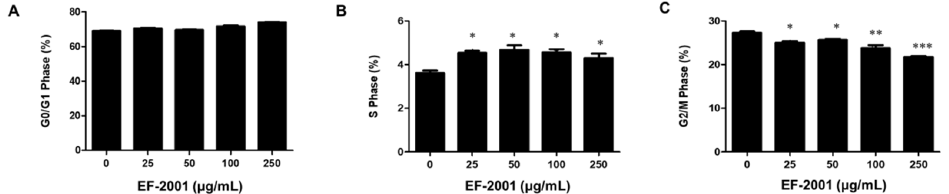
Figure 4. Effects of EF-2001 on MDI-induced cell cycle progression in 3T3-L1 adipocytes. MDI-treated 3T3-L1 preadipocytes were cultured with DM in the presence or absence of EF-2001. Cells treated with MDI for 48 h were stained with propidium iodine (PI) and analyzed by flow cytometry. The percentages of the cell population at G0/G1 ( A ), S ( B ), and G2/M ( C ) phase of the cell cycle were calculated from the data. Data are represented as mean ± SEM. ( n = 4); * p < 0.05, ** p < 0.01, and *** p < 0.001 vs. control (without EF-2001 in differentiation